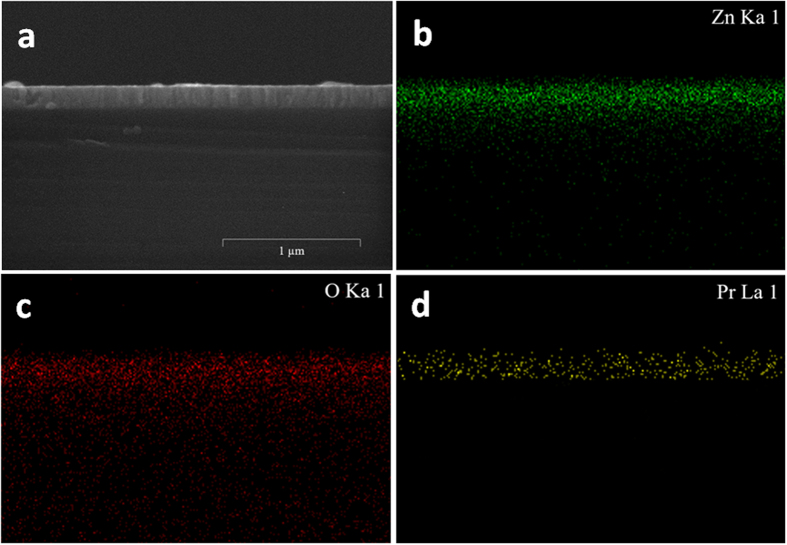
EDX mapping results on the cross-section of a typical sample prepared by hot-dipping ZnO0.81 thin film in Pr6O11 at 700 °C for 50 min in air.(a) EDX scanning area; and (b–d) EDX spectra of Zn, O and Pr, respectively.